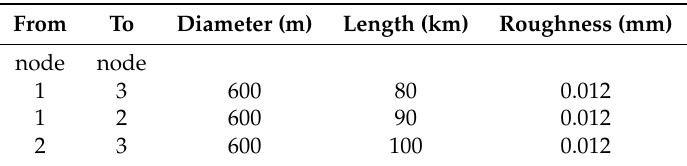
Table 3. The pipe’s geometrical data for a typical